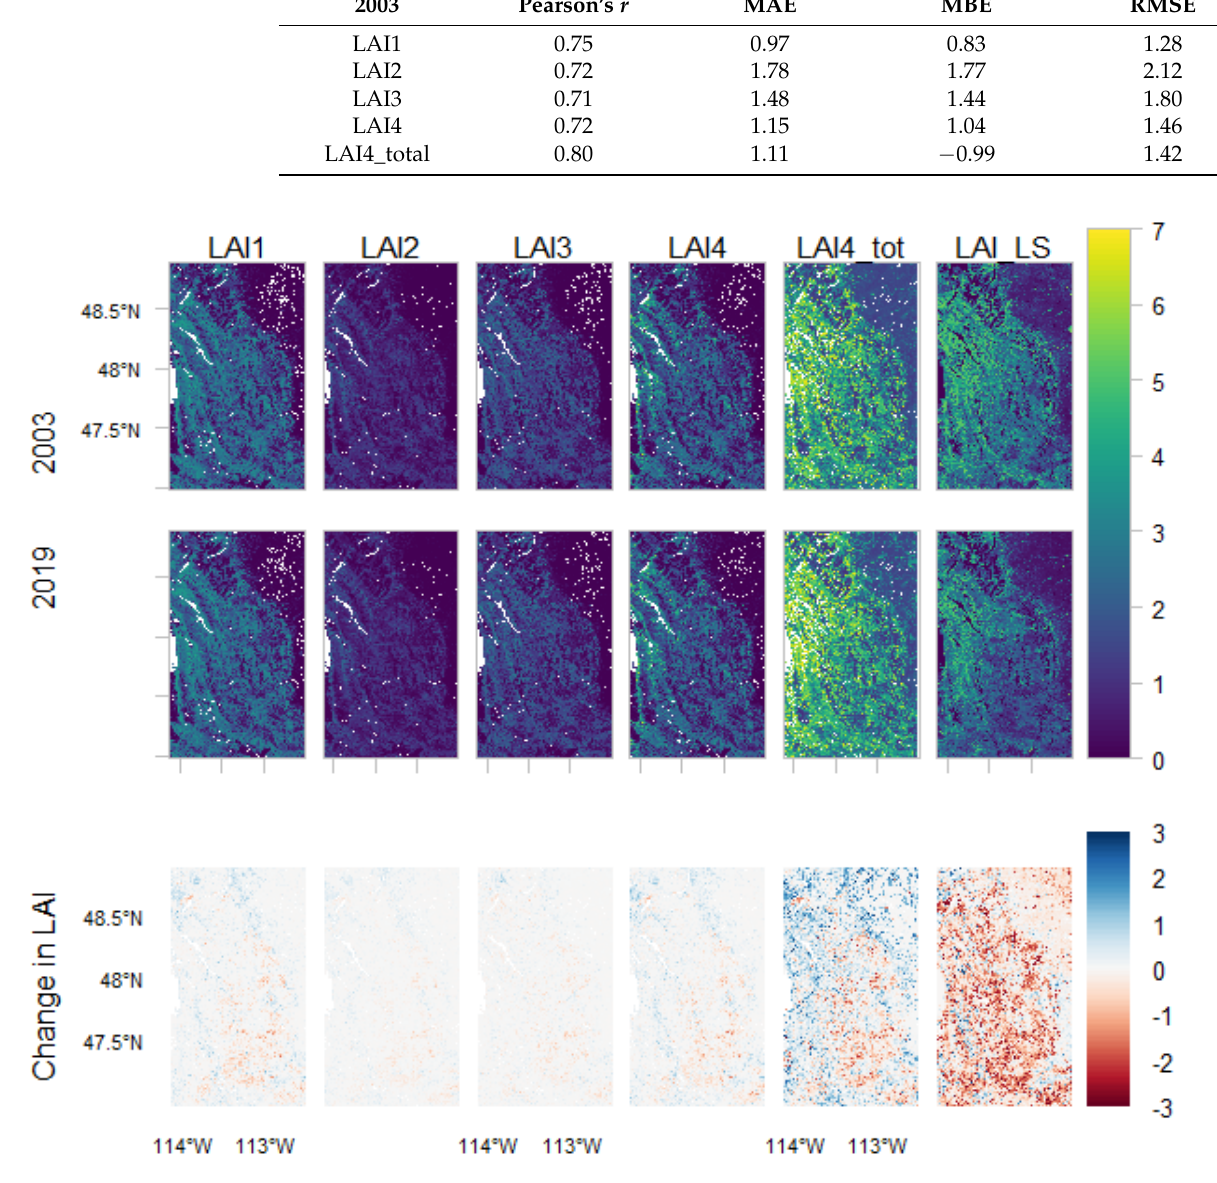
Table 5. Pixel-to-pixel comparisons of multiple gridded LAI datasets relative to Landsat-derived LAI as estimated for 2003. MAE = mean absolute error; MBE = mean bias error; RMSE = root mean squared error. LAI1, LAI2, LAI3, and LAI4, represent overstory LAI; LAI4_total represents the sum of overstory and understory LAI. 2003 Pearson’s r MAE MBE